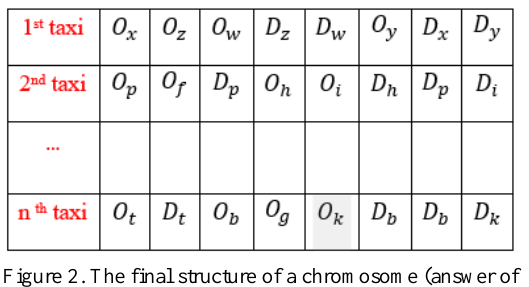
Figure 2. The final structure of a chromosome (answer of problem)